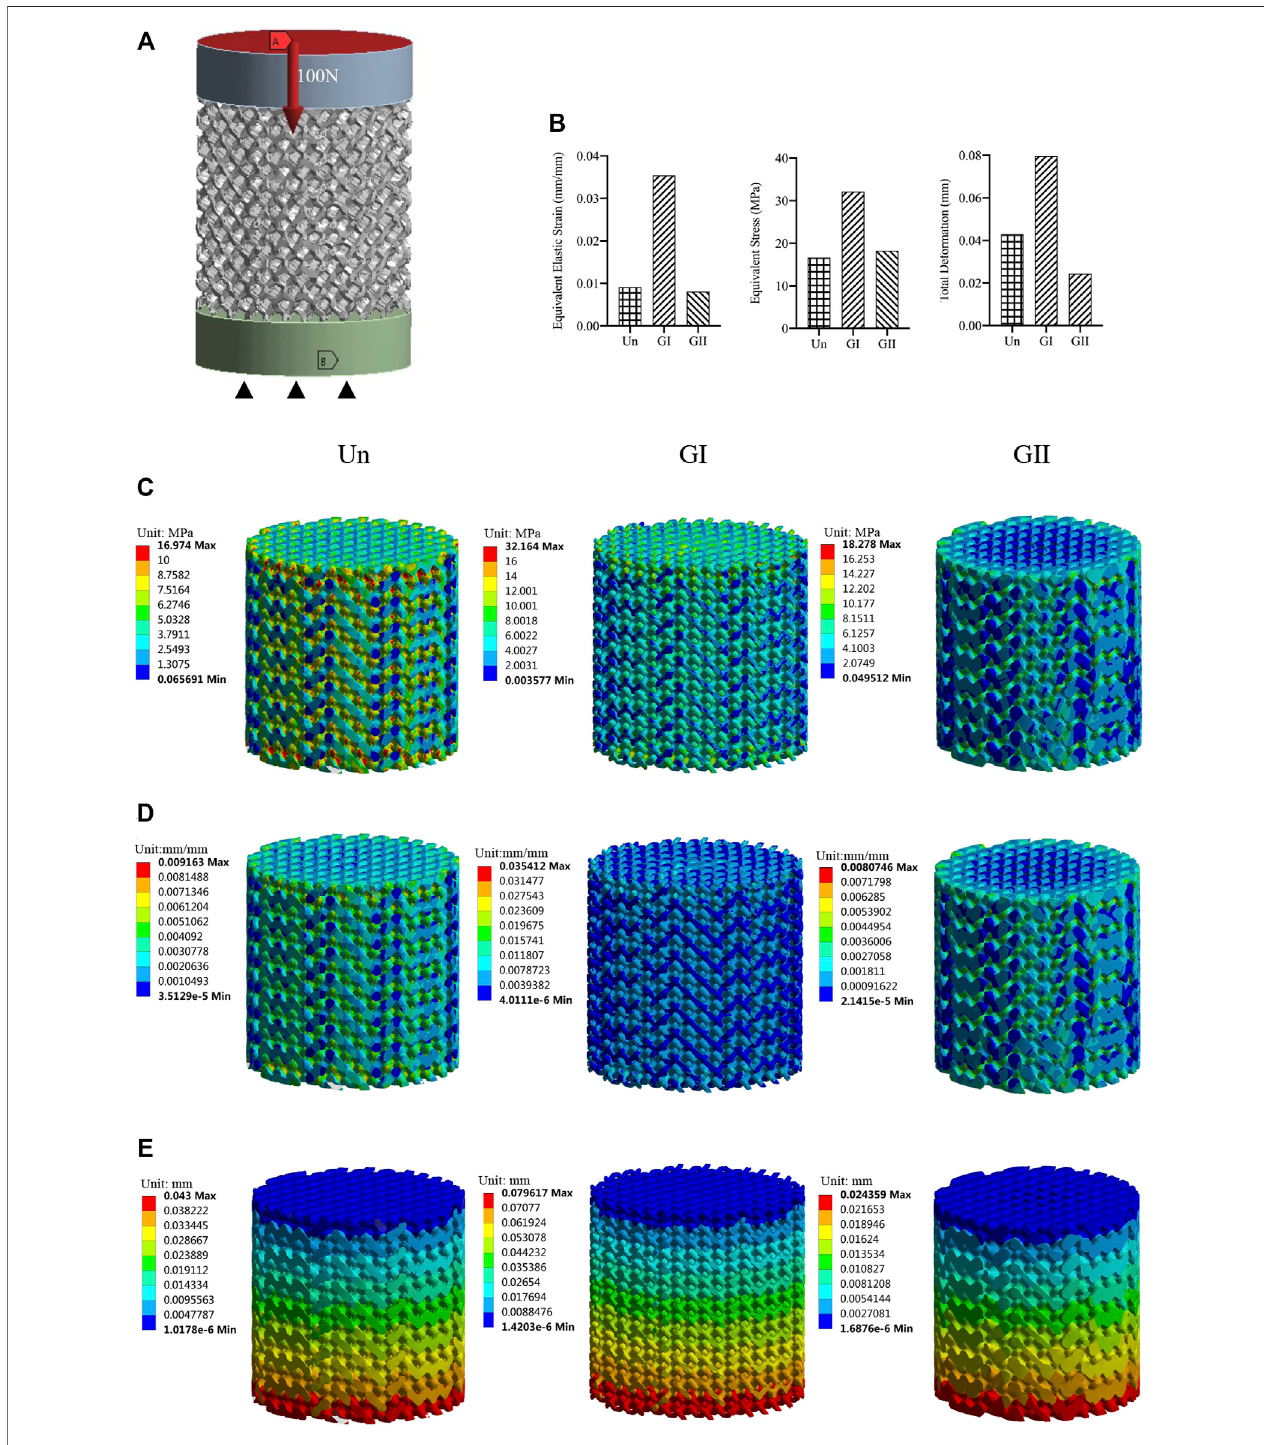
FIGURE3| MechanicalpropertiesevaluatedbyFEA. (A) Modelwithaverticalforce100 N; (B) Acolumnchartofstress,strain,displacement. (C) Equivalentstress changes with a vertical force of 100 N. (D) Equivalent elastic modulus changes with a vertical force 100 N. (E) Displacement with a vertical force 100 N.